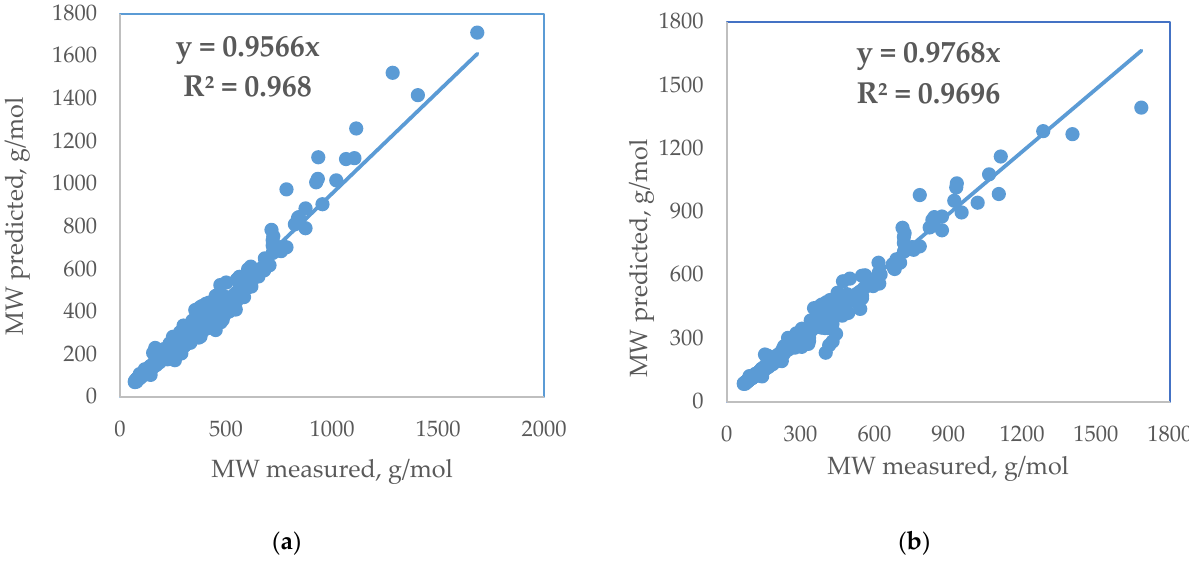
Figure 6. Parity graph for predicted versus measured molecular weight by Equation (7) (Goosens correlation) ( a ) and by Equation (11) (API method, 2011) ( b ).